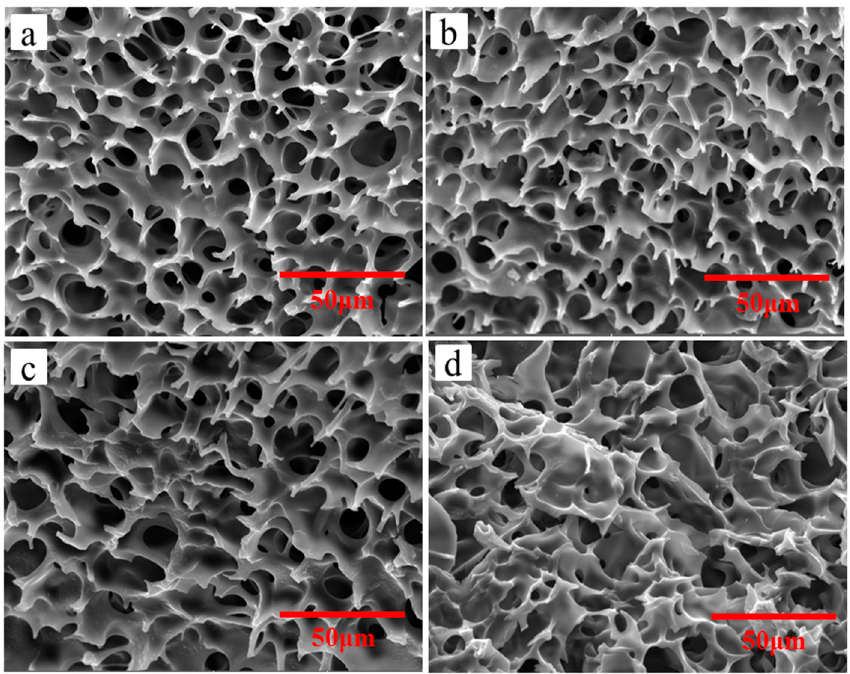
Figure 5. Micrograph of emulsions via different standing time: ( a ) 1 h; ( b ) 5 h; ( c ) 10 h; and ( d ) 24 h.